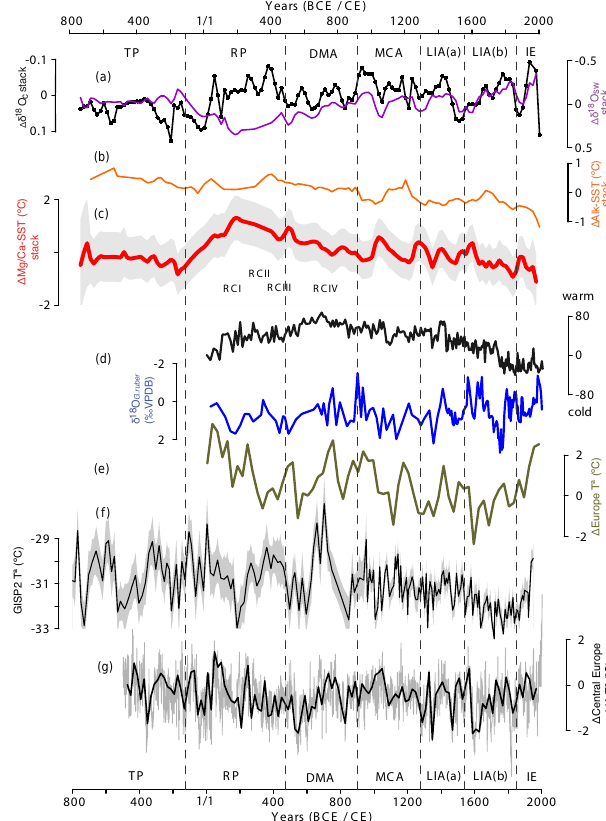
Figure 6. Temperature and isotope anomaly records from Minorca (this study) and data from other regions. (a) δ 18 O c and δ 18 O sw (‰ SMOW) Minorca stacks; (b) alkenone–SST anomaly Minorca stack; (c) Mg / Ca–SST anomaly Minorca stack; (d) warm and cold phases and δ 18 O G.ruber recorded by planktonic foraminifera from the southern Tyrrhenian composite core, with RCI to RCIV show- ing Roman cold periods (Lirer et al., 2014); (e) 30-year averages of the PAGES 2k Network (2013) Europe anomaly temperature recon- struction; (f) Greenland snow surface temperature (Kobashi et al., 2011); and (g) central Europe summer anomaly temperature recon- struction in central Europe (Büntgen et al.,